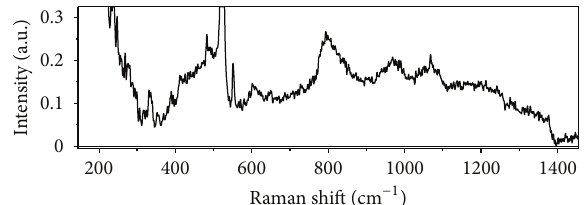
Figure 3: Raman spectrum measured for Si/LaLuO 3 sample, exci- tation wavelength 244 nm.